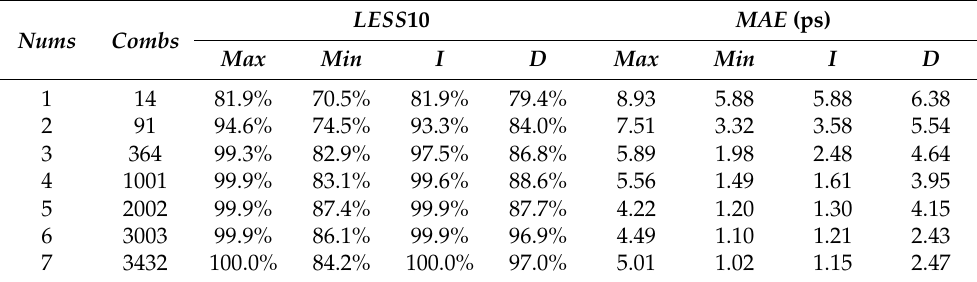
Figure 7. Performance evaluation of the two selection algorithms: Subfigures ( a – n ) show the evalua- tion of LESS 10 and MAE of two strategies on all designs. Plots of our iterative increase strategy (red) and the existing greedy deletion strategy (green). Table 5. Performance comparison